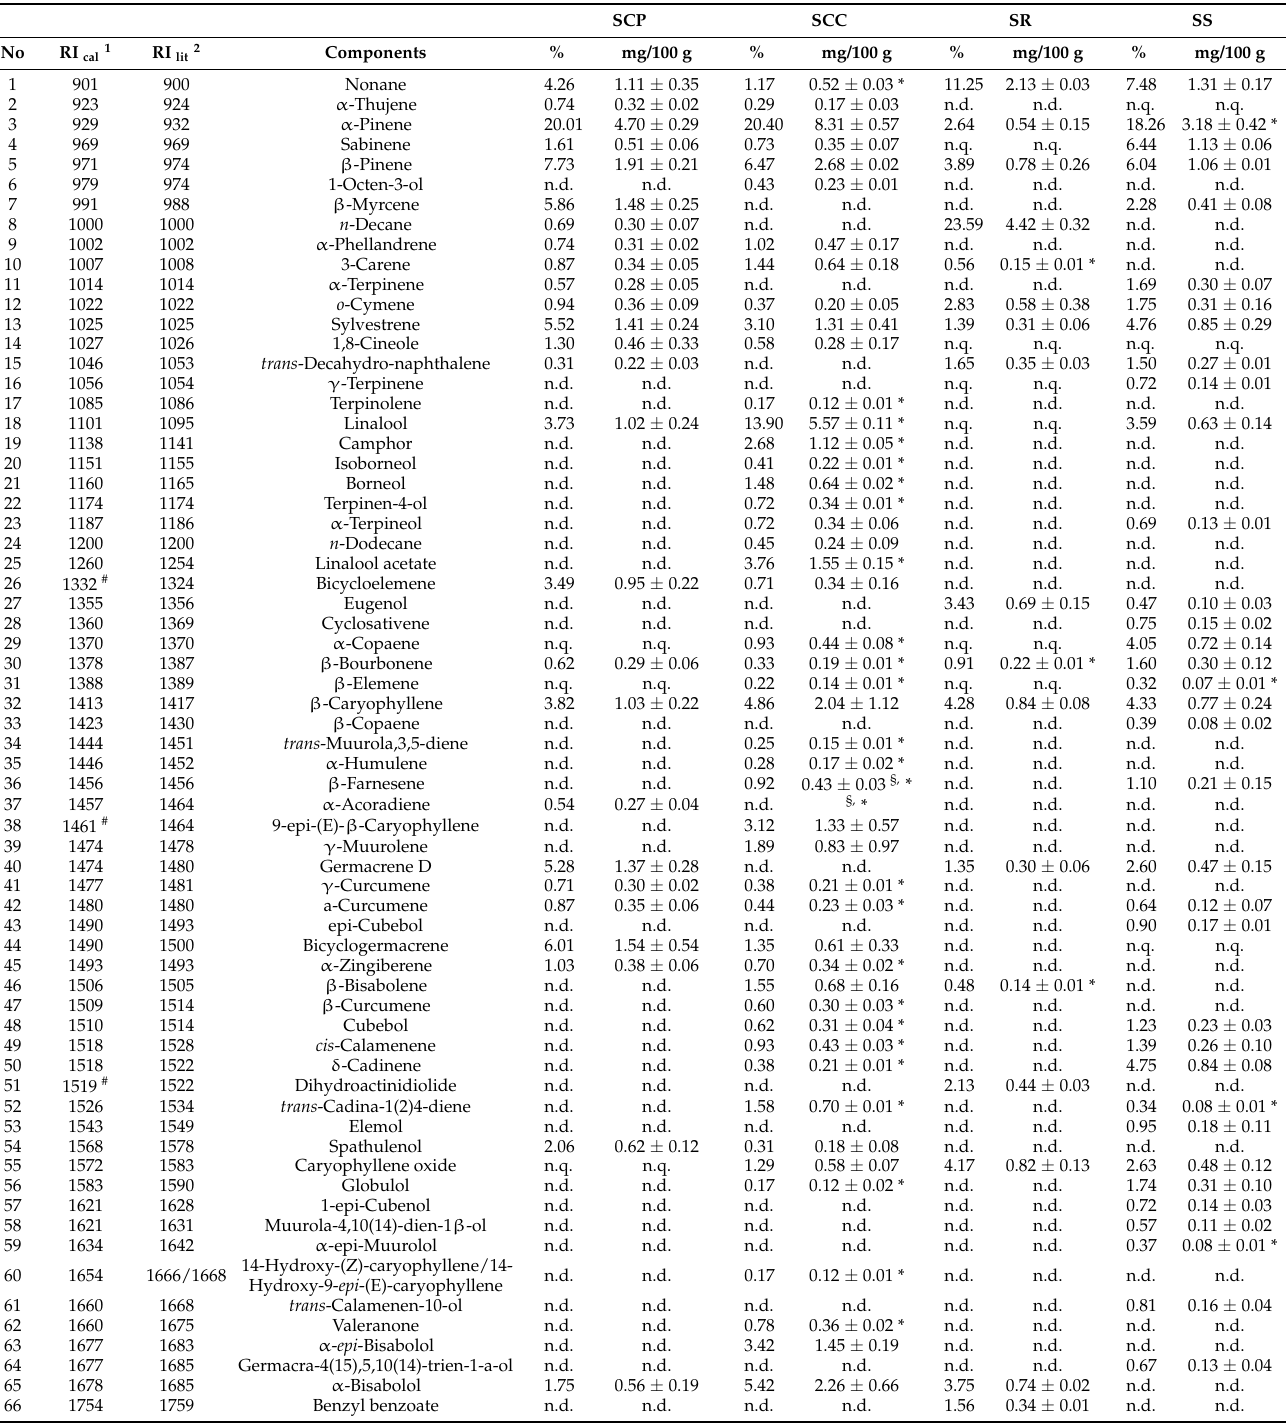
Table 4. Percentages and concentrations of volatile components identified in petroleum ether extracts of Sideritis clandestina subsp. peloponnesiaca (SCP), Sideritis clandestina subsp. clandestina (SCC), Sideritis raeseri subsp. raeseri (SR), and Sideritis scardica (SS) (2 biological samples, n = 2 for each sample). The percentages are expressed as normalized peak areas (peak area of component/peak area of internal standard). Concentrations are expressed as mg α -pinene equivalents/100 g dry plant material (average ± standard deviation). SCP SCC